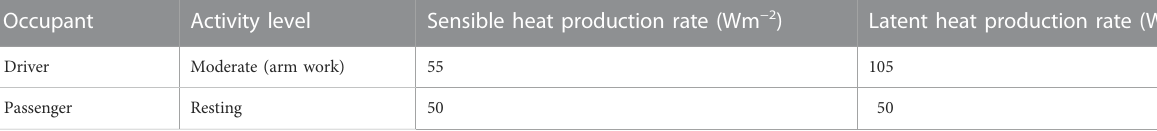
TABLE 1 Metabolic load calculation of a passenger car. Data taken from (Martinez et al., 2020).